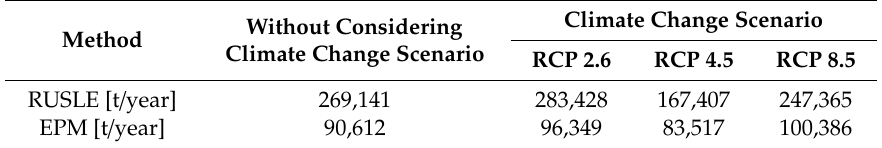
Table 12. Summary of the results considering a specific weight of 2.65 t / m 3